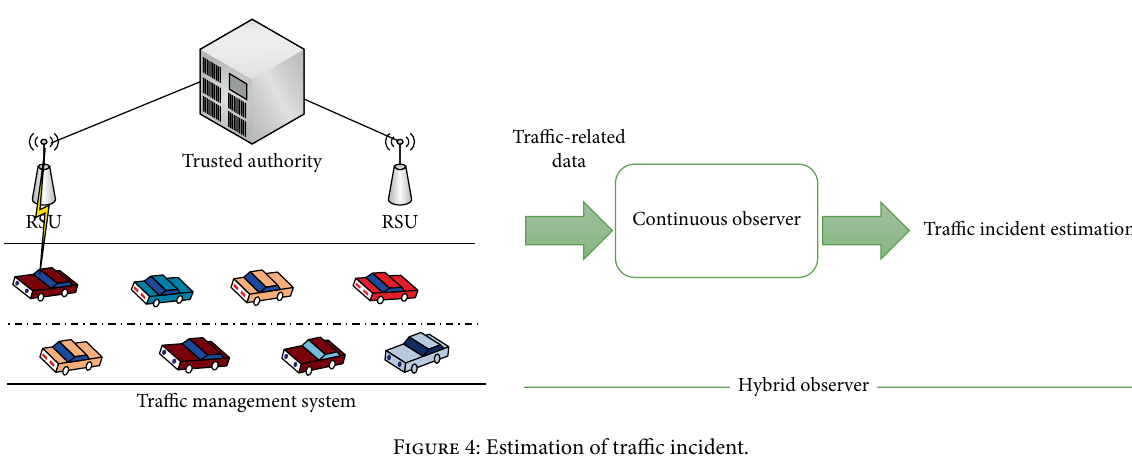
Figure 4: Estimation of traffic